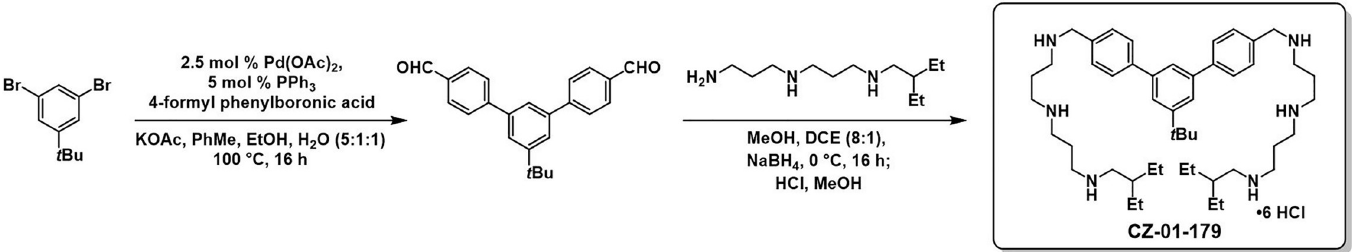
Fig 2. Schematic of CZ-01179 synthesis and resultant compound structure.